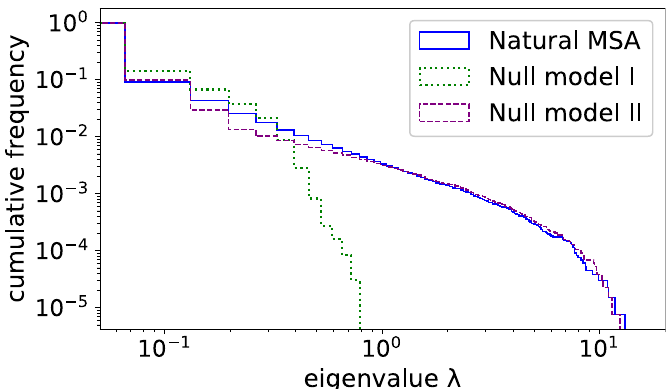
Fig 2. Eigenvalue spectra of the covariance matrix of the natural MSA and for Null models I and II. We show the cumulative distribution of the unified eigenvalue spectra for the 60-protein dataset DS2, i.e. the fraction of eigenvalues larger than λ is shown as a function of λ . We observe that the phylogeny-aware Null model II shows the same fat tail for large eigenvalues, which is also present in the natural data, while the non-phylogenetic Null model I has a more compact support. The cutoff of the tail for large λ is an effect of the inter-family variability of the largest eigenvalues among the 60 spectra, cf. Fig D in S1 Text for the 9 individual proteins in dataset DS1.